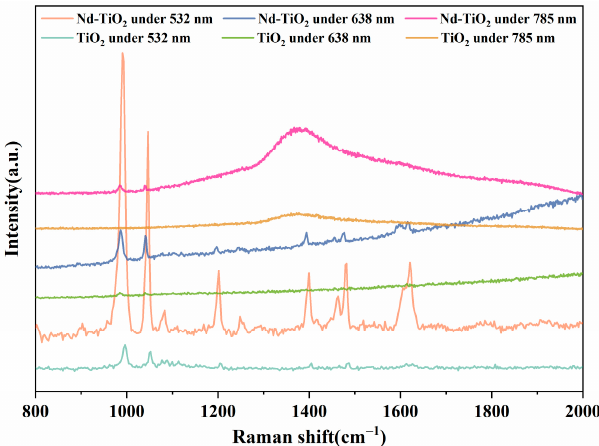
Figure 7. SERS spectra of 4-Mpy adsorbed on Nd-TiO 2 and TiO 2 NPs under 532, 638, and 785 nm laser excitation. laser excitation.